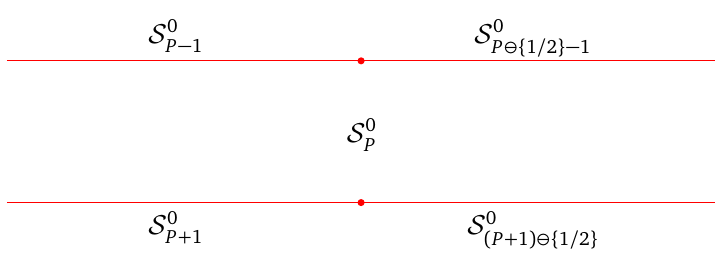
Figure 14: Connectivity of the infinite strips S 0 surface ˇ R . The red dots represent ramification points for the covering map ˇ ρ sending all the strips to the infinite cylinder C